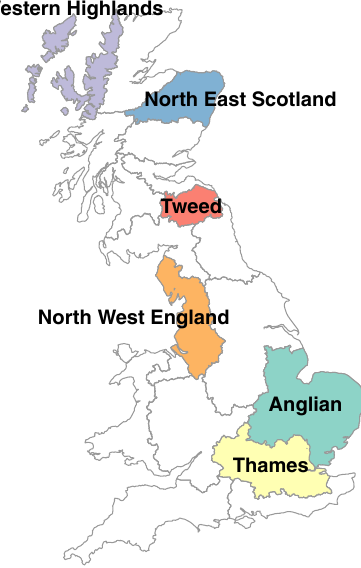
Figure 7. Subset of six river basin regions in Great Britain used in the analysis. All 19 UKCP09 river basin regions are shown in Fig. S3.